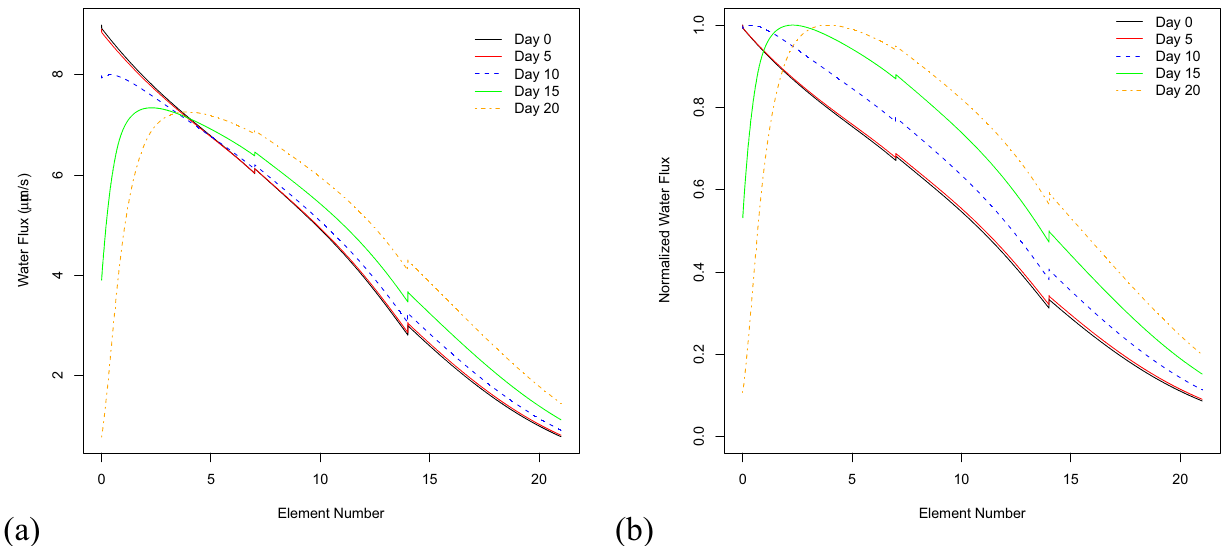
Fig. 10 Model illustration of local fl ux pro fi les before and after bio fi lm growth. Absolute ( a ) and normalized ( b ) permeate fl ux pro fi les from inlet to outlet of the RO system illustrating the drop in fl ux at the inlet where the bio fi lm initially forms and the shift in fl ux downstream as the bio fi lm grows from the plant inlet downstream over time.